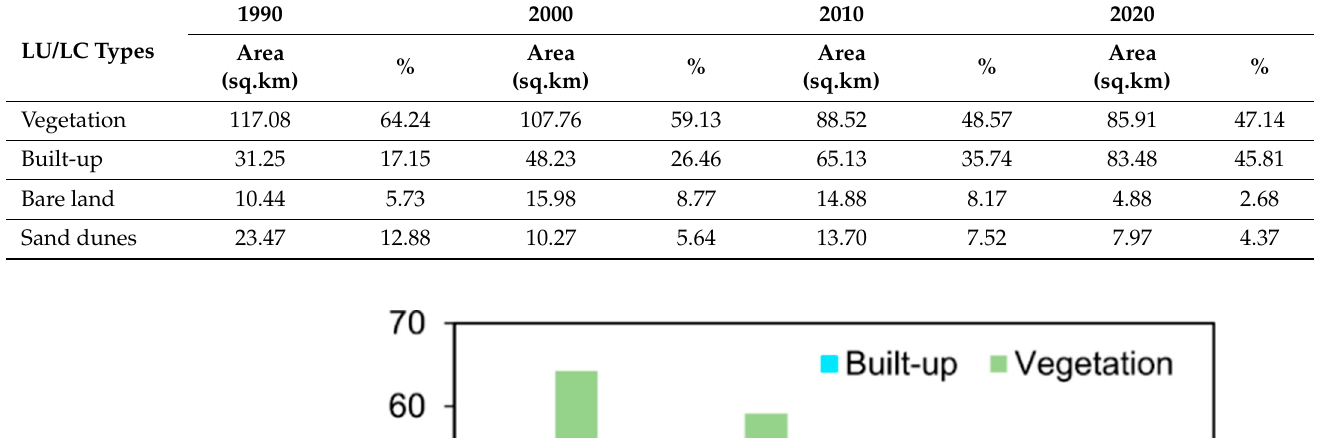
Table 3. A summary of area coverage of LULC classes over the 30 year study period.